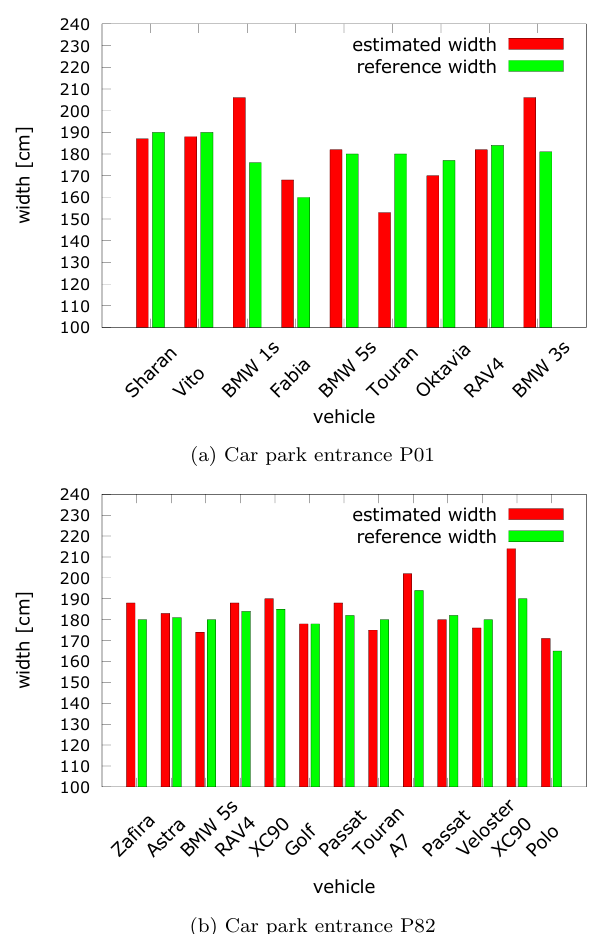
Figure 7: Comparison of the measurement and reference values for the width measurement with fixed reference